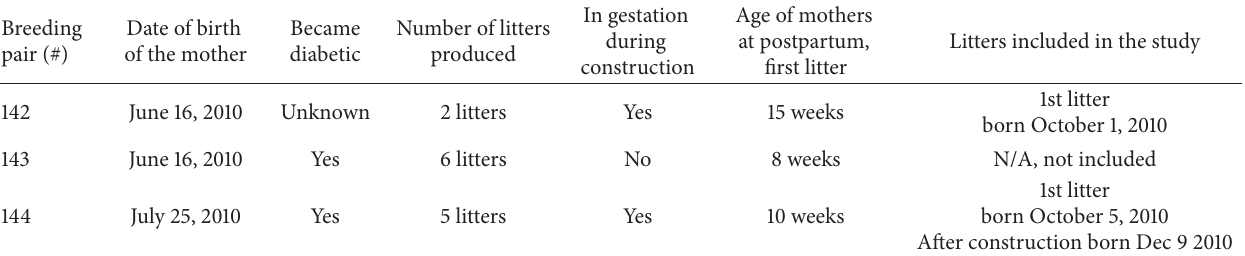
Table 1: Description of the mothers and litters from the NOD/LtJ-HMR mouse colony used in this study. Breeding pair